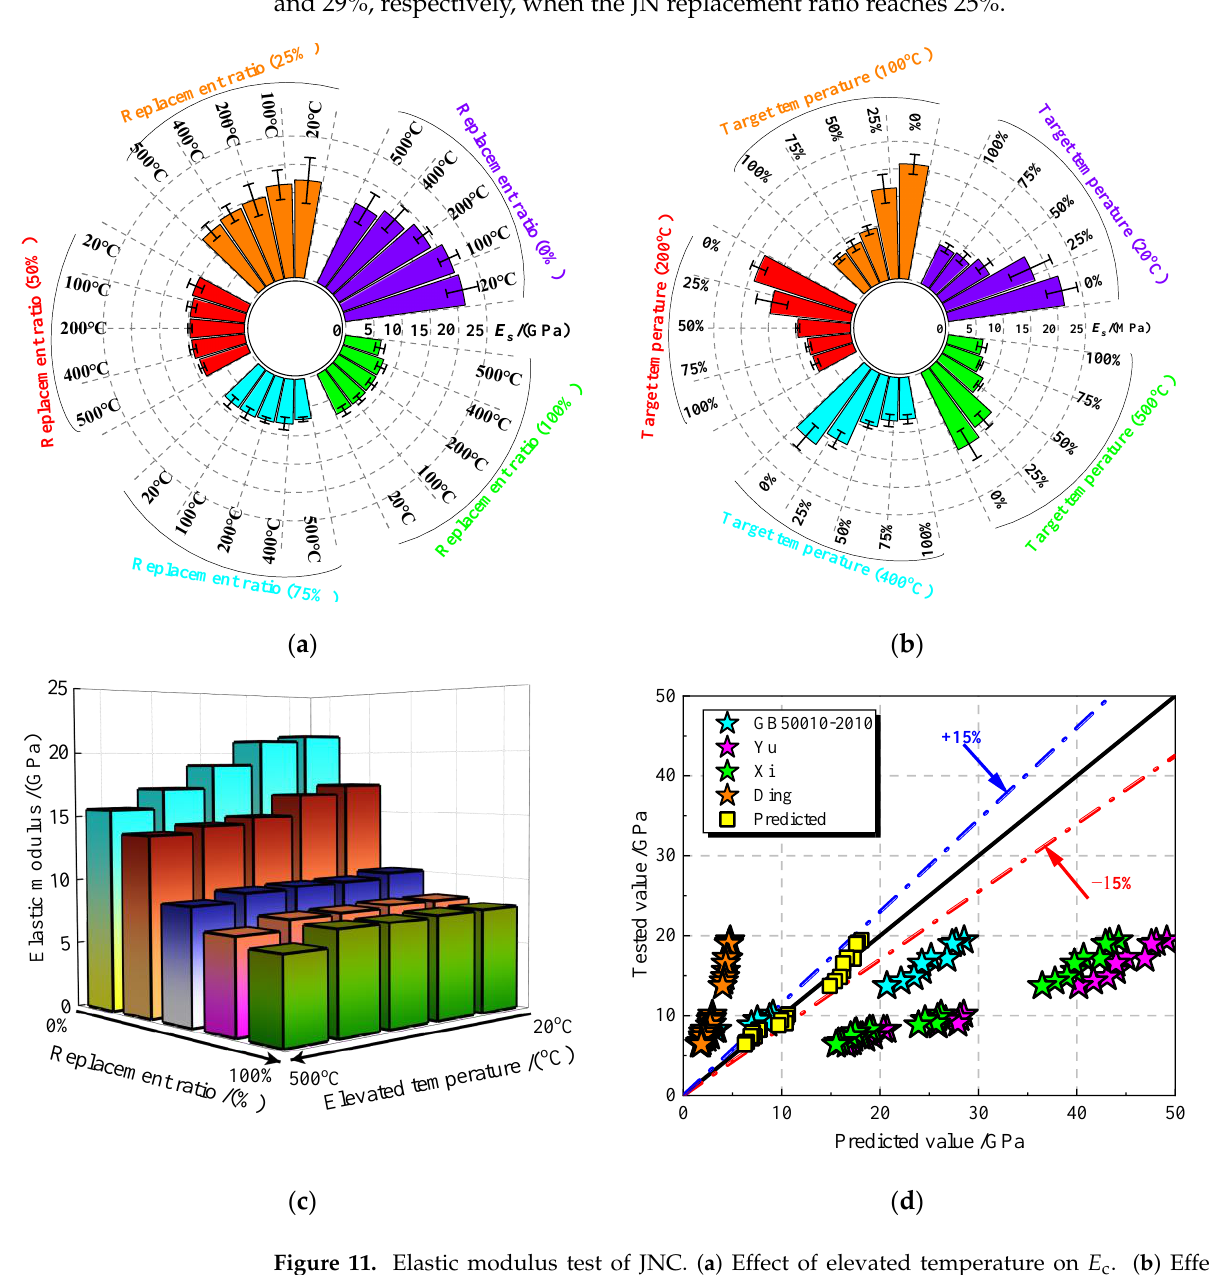
Figure 11. Elastic modulus test of JNC. ( a ) Effect of elevated temperature on E c . ( b ) Effect of replacement ratio on E c . ( c ) Variation of E c under the effect of replacement ratios and elevated temperatures. ( d ) Comparison of the tested values and the predicted values [34–37]. To predict the elastic modulus of concrete materials, Equations (4) and (5) are recom- mended by GB/T 50010-2010 [34] and Yu [35] (a = 20805, b = 0.29), respectively, to predict the elastic modulus of ordinary concrete, whilst Equation (6) is put forward by Xi [36] (a = 1.60, b = 1.347, and c = 0.275) and Ding [37] (a = 2.09, b = 1, c = 0.25) to calculate the elastic tested values and the predicted values. It can be seen that Ding is prone to overestimate the elastic modulus of JNC, while the formulas from Yu, Xi, and GB 50010-2010 are inclined to underestimate the elastic modulus of JNC. Therefore, Equation (7) is proposed